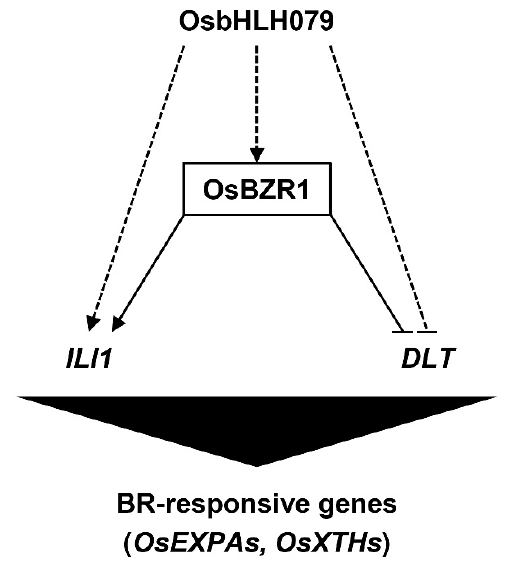
Figure 8. A proposed model of the OsbHLH079-mediated regulatory network in the BR signaling pathway. OsbHLH079 enhances brassinosteroid signaling by upregulating genes encoding positive regulators of the BR signaling pathway, such as OsBZR1 , and ILI1 , and downregulating DLT , which also encodes a positive regulator of BR signaling and downregulated directly by OsBZR1. Then, altered expressions of BR-responsive genes such as OsEXPA , and OsXTH produce changes in leaf angle and grain length. Arrows and bars indicate positive and negative regulation, respectively. Solid and dashed lines indicate direct regulation and possible feed-forward regulation, respectively.